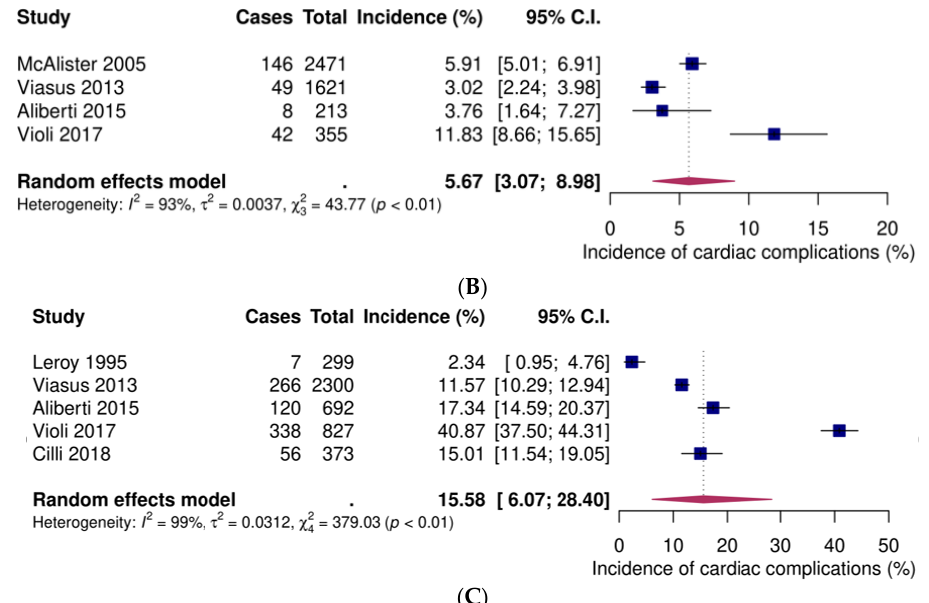
Figure 2. Forest plots of incident overall cardiac complications after community-acquired pneumonia.